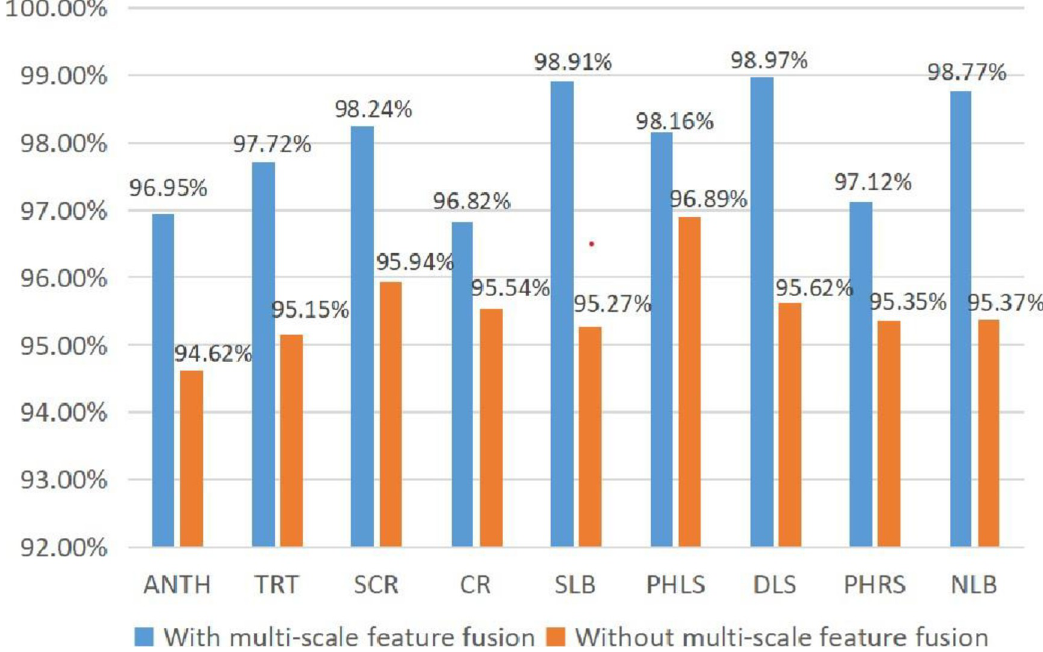
Fig 10. Effect comparison chart of multi-scale feature fusion.